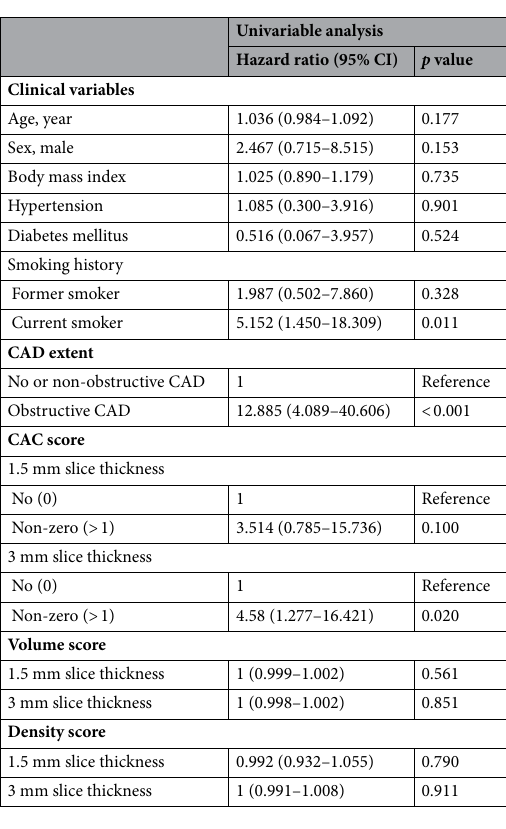
Table 4. Univariable Cox regression analysis for prediction of MACE. MACE Major adverse cardiovascular events, CAD Coronary artery disease, CAC Coronary artery calcium.